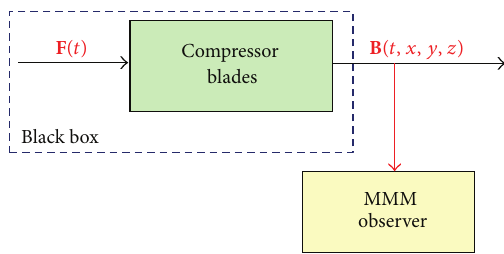
Figure 13: Signal analysis of the blade magnetizing (magnetic induction B in the close of the its surface) which the health monitoring and load history of the blade